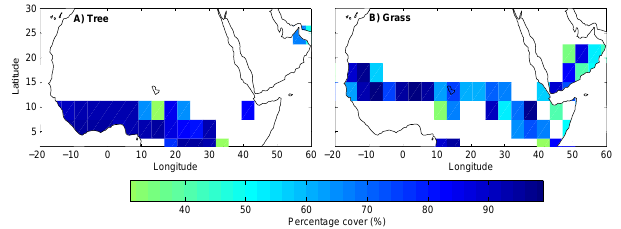
Figure 1. Pre-industrial vegetation cover over North Africa sim- ulated by CCSM3-DGVM. (a) Percentage coverage of tree PFTs; (b) the same for